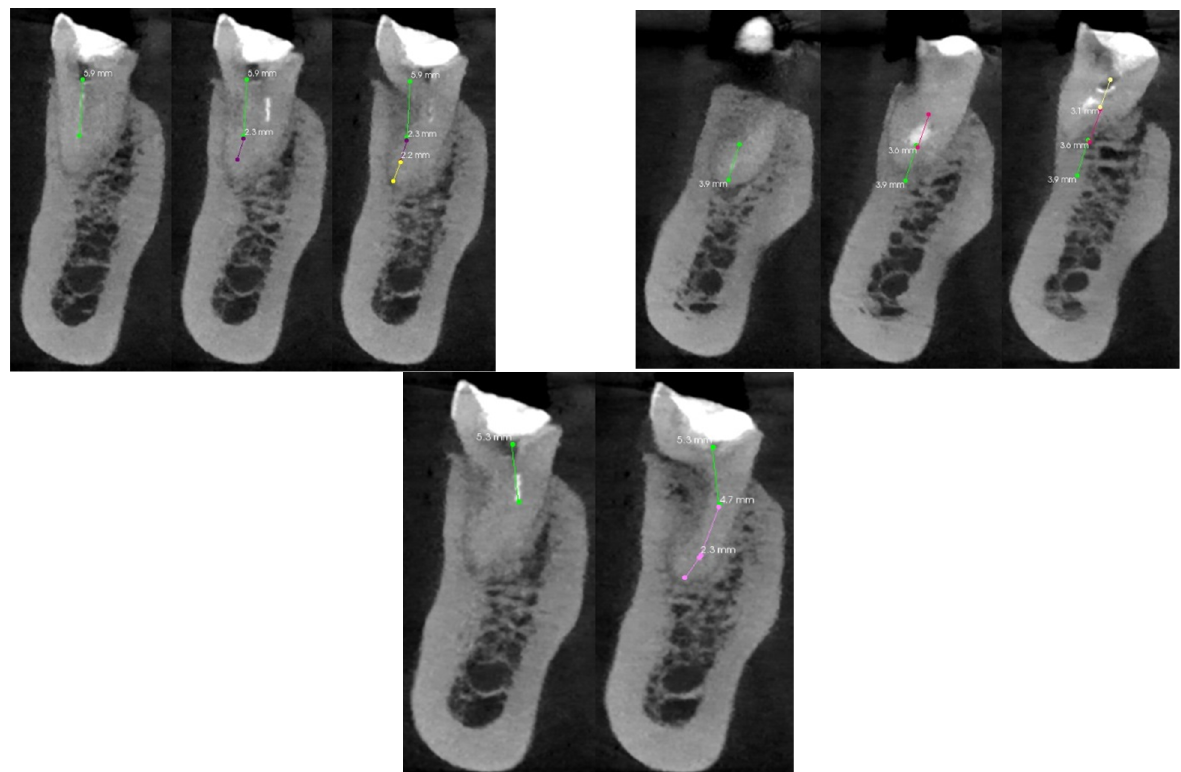
Figure 15. The CT scan of the tooth was used for the analysis of the root canals in the transverse plane, in the case of tooth 46.